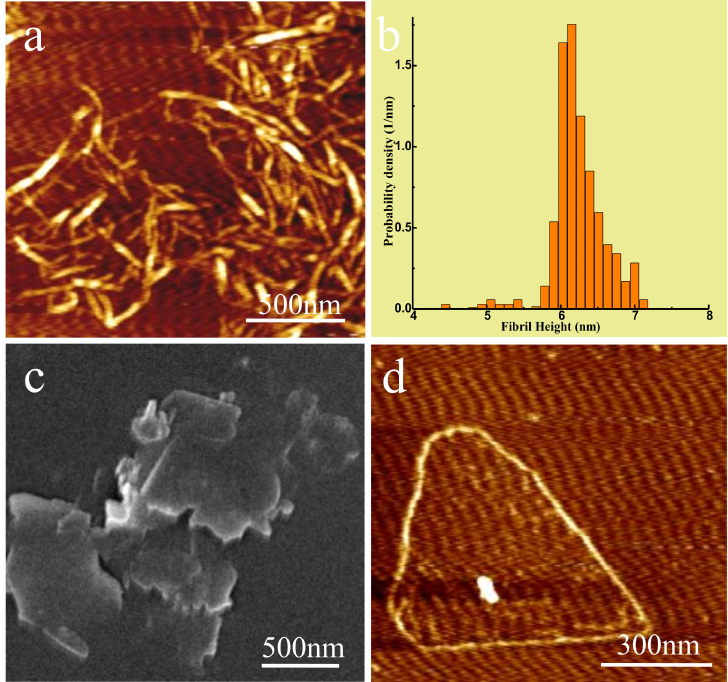
Figure 2. ( a ) AFM image of CNF, ( b ) The corresponding height distribution measured from AFM topographic data of CNF, ( c ) SEM Image of BNNS, ( d ) AFM image of